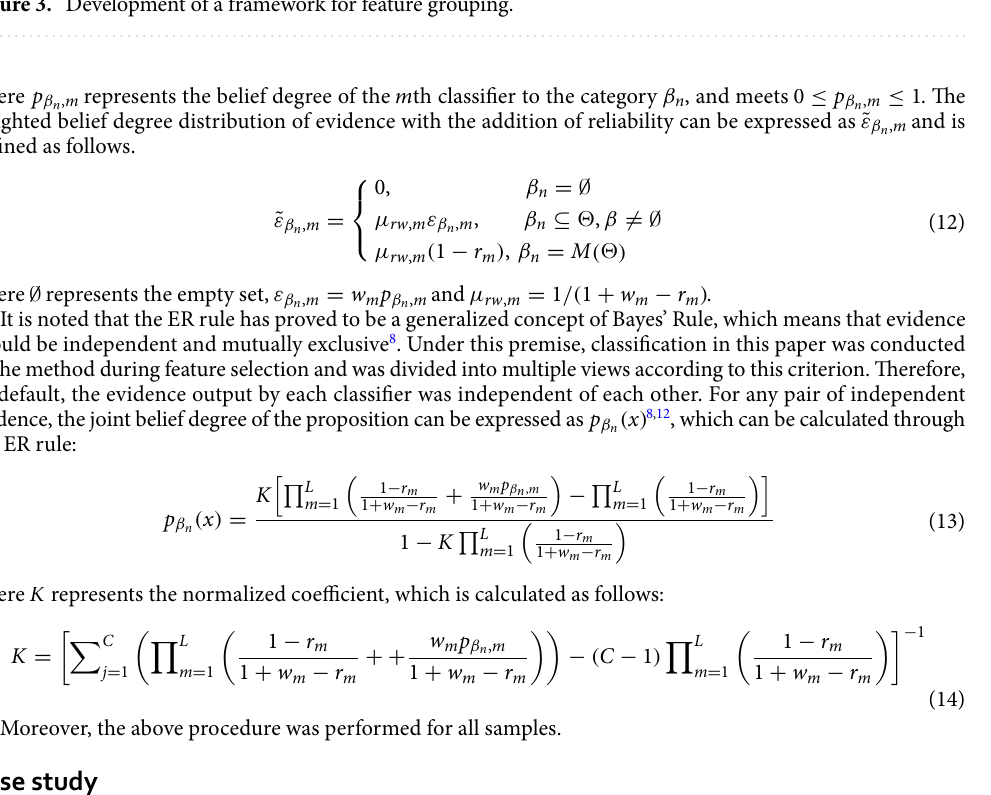
Figure 3. Development of a framework for feature